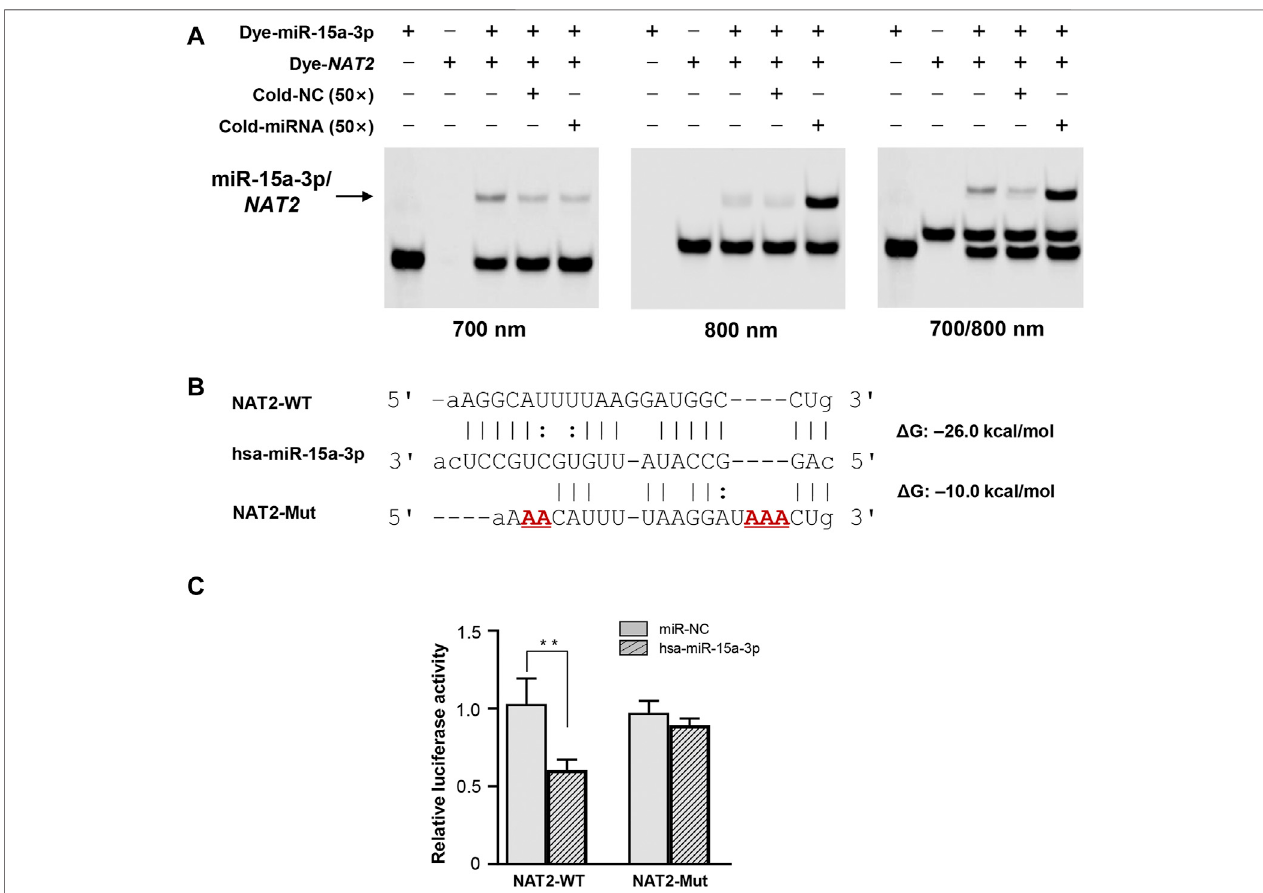
FIGURE 1 | The hsa-miR-15a-3p oligonucleotides interacted with NAT2 mRNA oligonucleotides in vitro and inhibited luciferase reporter gene expression. (A) Lanes 1 and 2 represented the hsa-miR-15a-3p and NAT2 RNA oligonucleotides, respectively; lane 3 represented the formation of miRNA:mRNA complex; lane 4 represented the formation of miRNA:mRNA complex in the presence of excess unlabeled nonspeci fi c competitors; lane 5 represented the formation of miRNA:mRNA complex in the presence of excess labeled speci fi c competitors. NC, nonspeci fi c competitor. (B) Free energy analyses of miRNA: mRNA duplex formed by hsa- miR-15a-3p and wild or mutated response elements in 3 ′ -UTRs of NAT2 (the RNAhybrid algorithm). (C) Constructs containing the wild or mutant type sequence of the core 3 ′ -UTRs of NAT2 gene were transiently transfected into HEK293T cells, respectively, together with 50 nmol/L hsa-miR-15a-3p mimic or miRNA negative control. Cells were harvested 48 h after transfection. The data represented three independent experiments, each in triplicate reactions, were shown as mean ± SD. ** p <